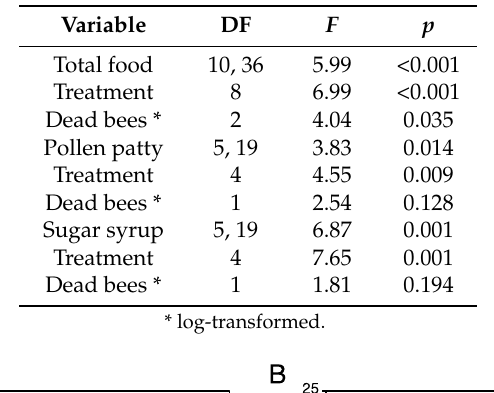
Table 1. Results from a multivariate statistical test of experimental Treatment effects on total amount of food consumed, and separate univariate tests on pollen patty and sucrose in sugar syrup consumed, by caged honey bees over two weeks.